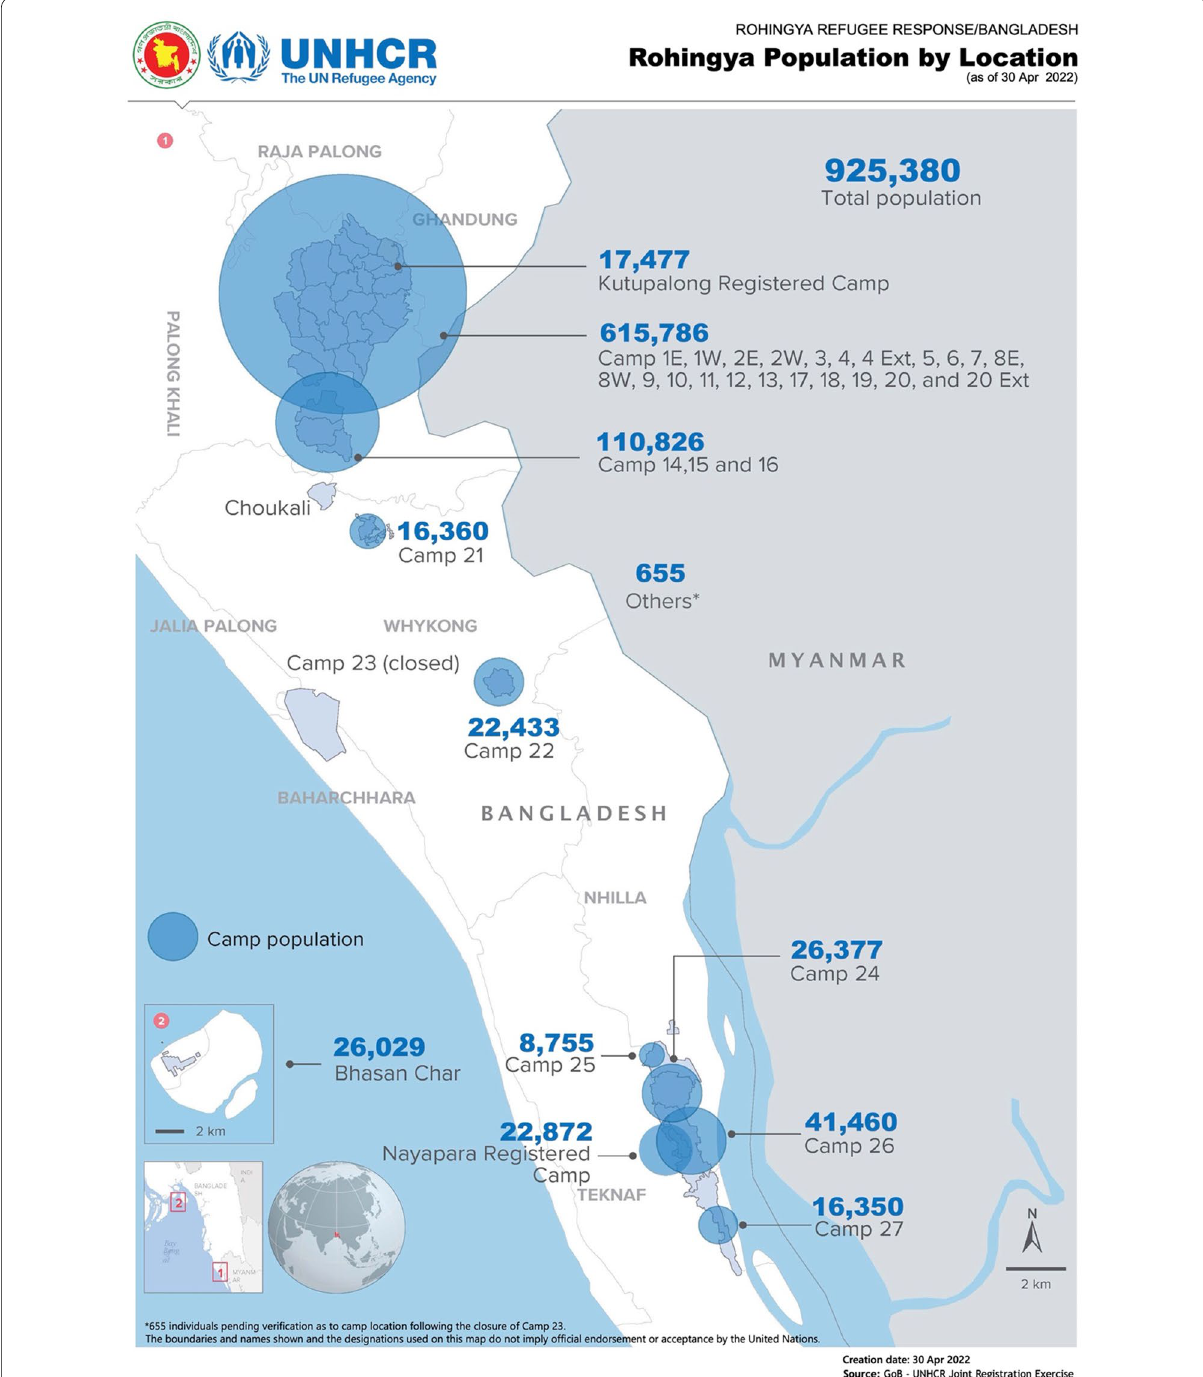
Fig. 9 Joint Government of Bangladesh and UNHCR Rohingya Population map in Bangladesh as of 30 April 2022. Source UNHCR